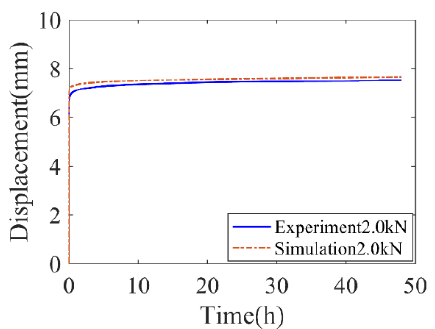
Figure 18. Comparison of numerical and experimental creep deformation of the rubber system at room temperature.